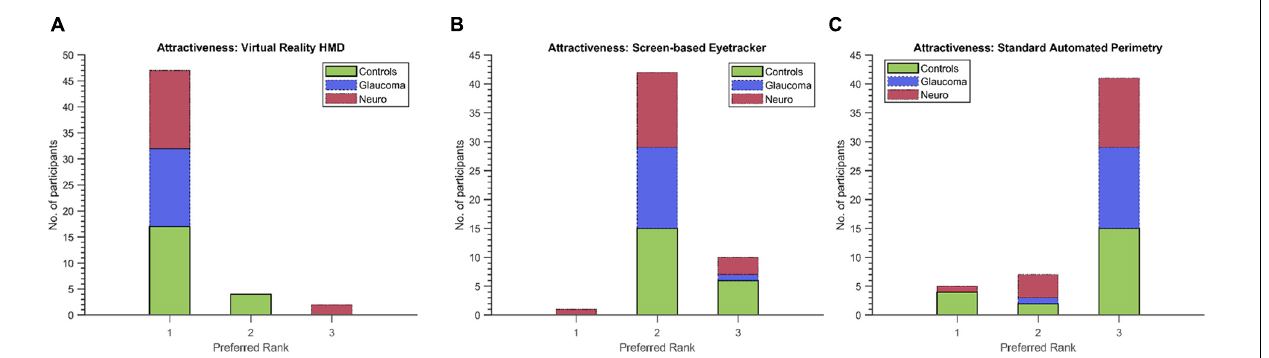
FIGURE 6 | Preferred ranks for the three modalities ( A : VR, B : Screen-based eyetracker, C : SAP) in the Attractiveness dimension of the UEQ. Forty-seven (including 17/21 controls, 15/15 glaucoma patients and 15/17 neuro-ophthalmic patients) of the total 53 participants rated the VR setup as the most attractive compared to only 5 (four controls and a neuro-ophthalmic patient) for the conventional